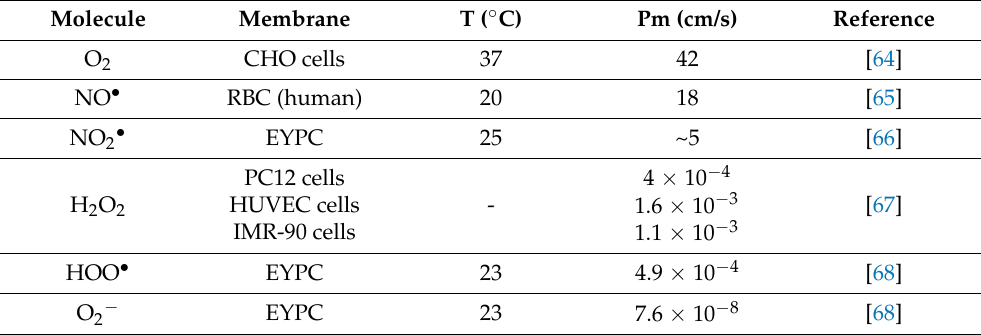
Table 5. Permeability coefficients (Pm) of some reactive